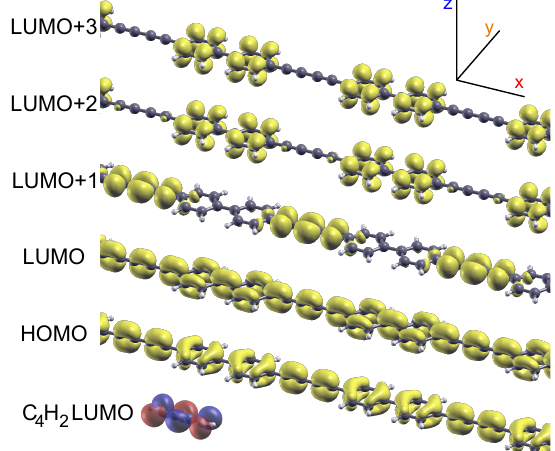
Figure 4. Isosurfaces corresponding to a squared-wavefunction amplitude of 0.01 Å − 3 , for the highest occupied (HOMO), the lowest unoccupied (LUMO), and a few more empty electronic states of the freestanding bBEBP polymer (in the geometry shown in Figure 3a, but without the Au surface atoms). For comparison to the LUMO + 1, the LUMO computed for C 4 H 2 is shown at the